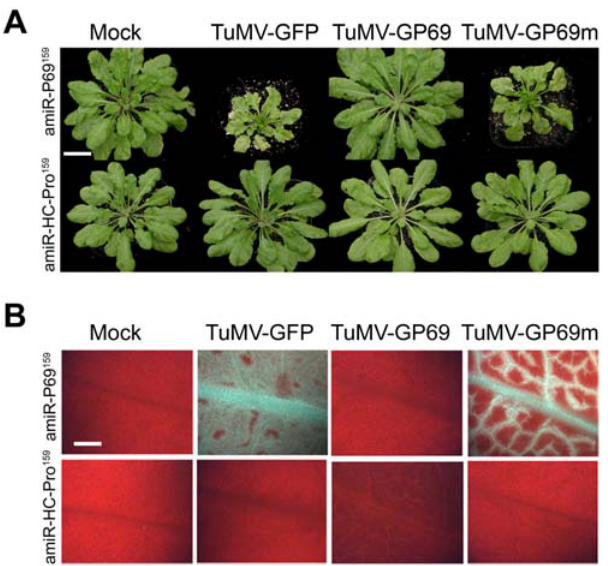
Figure 2. A 21-nt sequence targeted by amiRNA is necessary and sufficient to confer virus resistance. (A) amiR 159 -P69 and amiR 159 -HC-Pro transgenic Arabidopsis plants were mock-inoculated or inoculated with TuMV-GFP, TuMV-GP69, or TuMV-GP69m. As controls, the same transgenic lines were inoculated with TuMV-GFP. Photo- graphs were taken at 12 dpi. Bar=0.5 cm. (B) GFP fluorescence of systemic leaves of plants infected with chimeric viruses. Leaves were examined by fluorescence microscopy. Leaves of sensitive amiR 159 -P69 plants displayed green fluorescence due to replication of GFP-virus, whereas no green fluorescence was detected in leaves of resistant amiR 159 -HC-Pro or amiR 159 -P69 plants. Bar=2 cm.